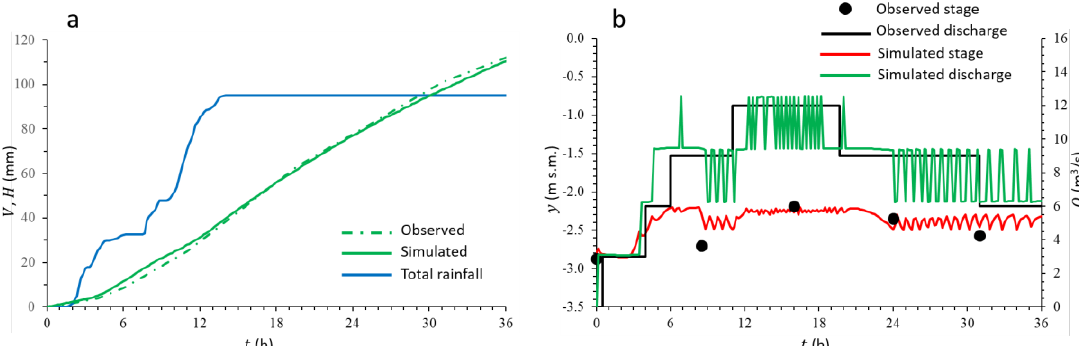
Figure 7. Event of 1 November 2002, comparison between observation and simulation at the Stagni pumping station: ( a ) water volumes (per unit catchment area) pumped and the total rainfall, ( b ) water levels and flow rates at the pumping station.